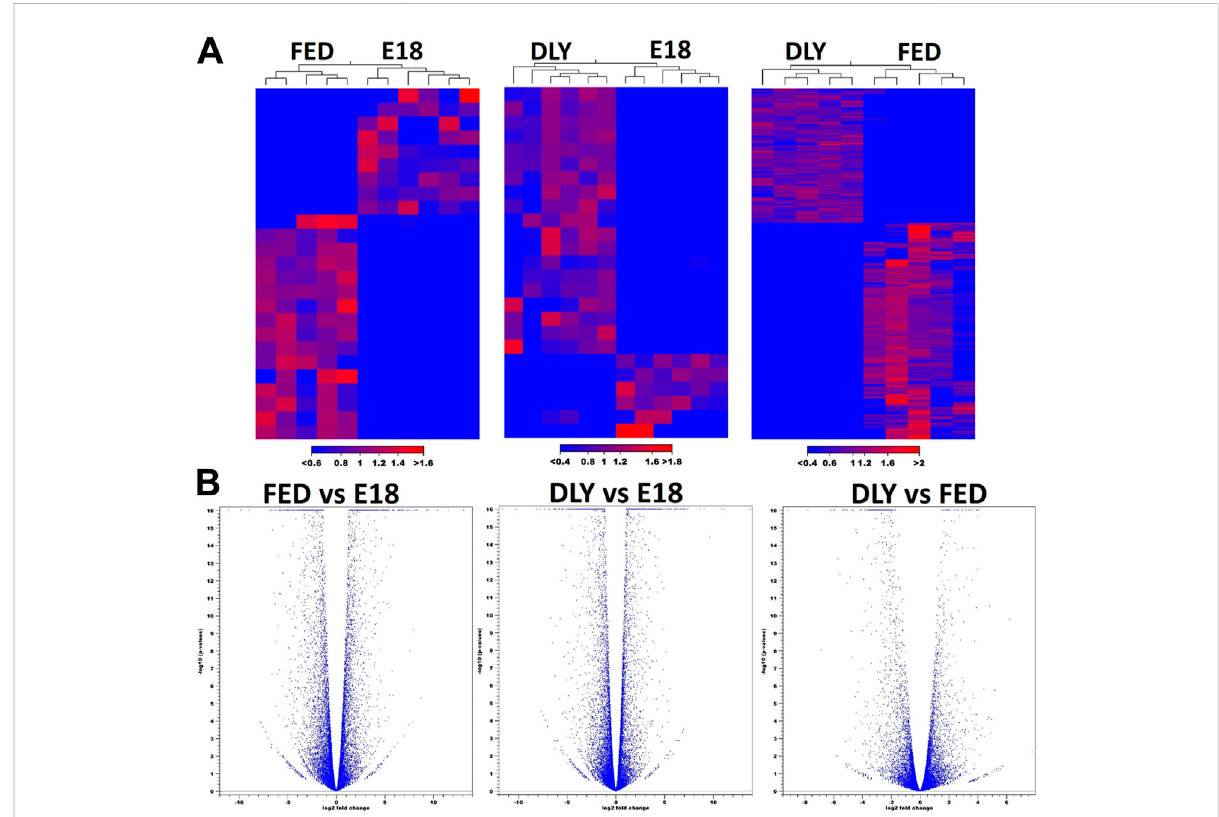
FIGURE 2 Heatmap anlaysis and volcano plot distributions of differentially expressed genes between E18 embryos and D2 fed-from-hatch (FED) chicks, E18 and D2 delayed-fed chicks (DLY) and between DLY and FED. (A) Heatmap analysis of differentially expressed genes (fold-change ≥ 2; FDR p -value ≤ 0.05) between E18 embryos and D2 fed-from-hatch (FED) chicks, E18 and D2 delayed-fed chicks (DLY) and between DLY and FED. Expression values used are normalized log CPM values. Red indicates higher expression and blue indicates lower expression. (B) . Volcano plots of FED vs. E18, DLY vs. E18, and DLY vs. FED pairwise comparisons. (fold-change ≥ 2; FDR p -value ≤